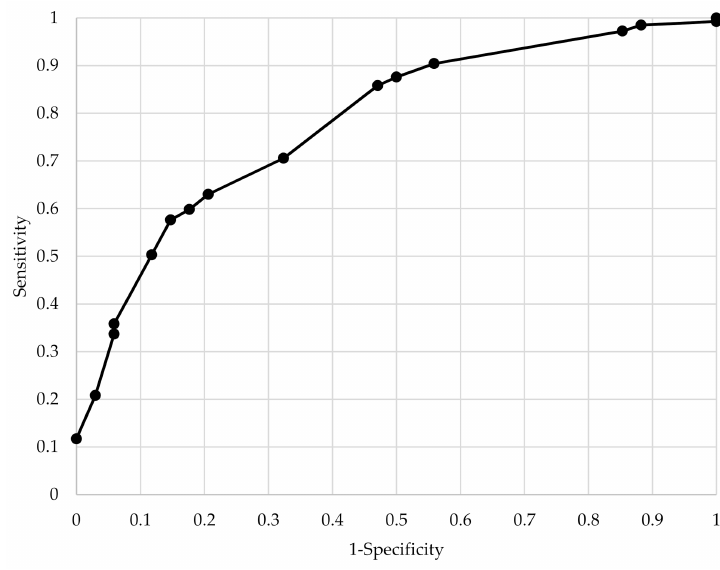
Figure 1. ROC curve for the